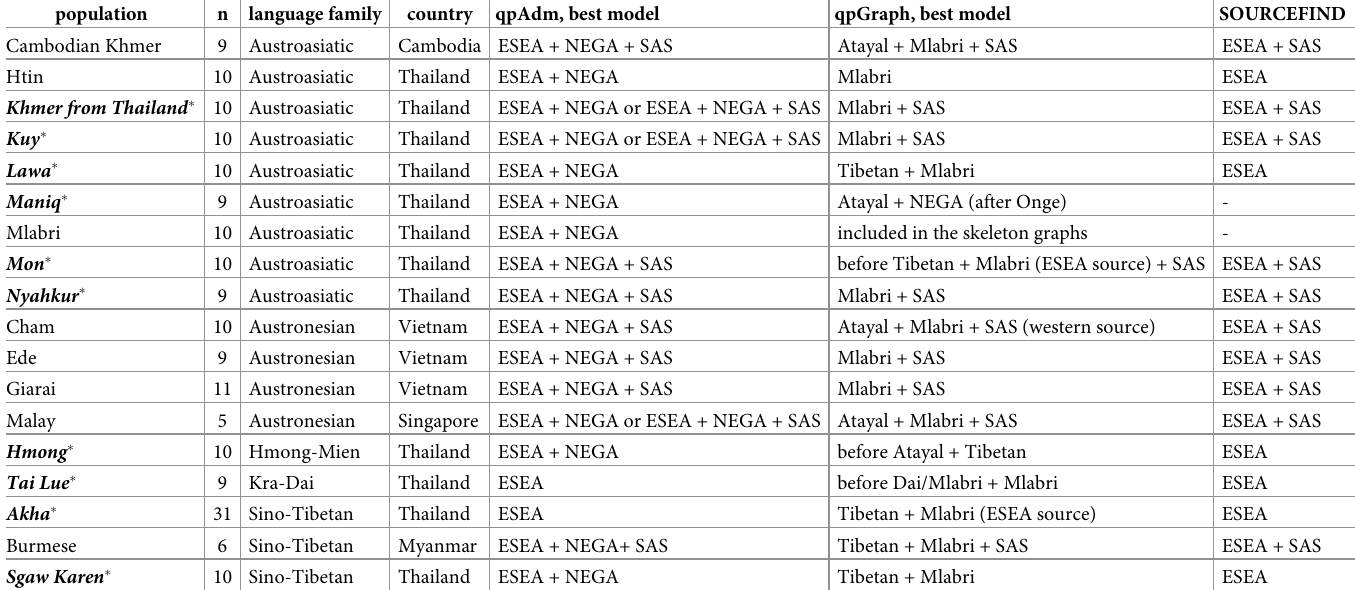
Table 1. A summary of qpAdm , qpGraph , and SOURCEFIND admixture modelling results for the groups of interest. Labels of groups genotyped in this study are ital- icized and marked with asterisks.